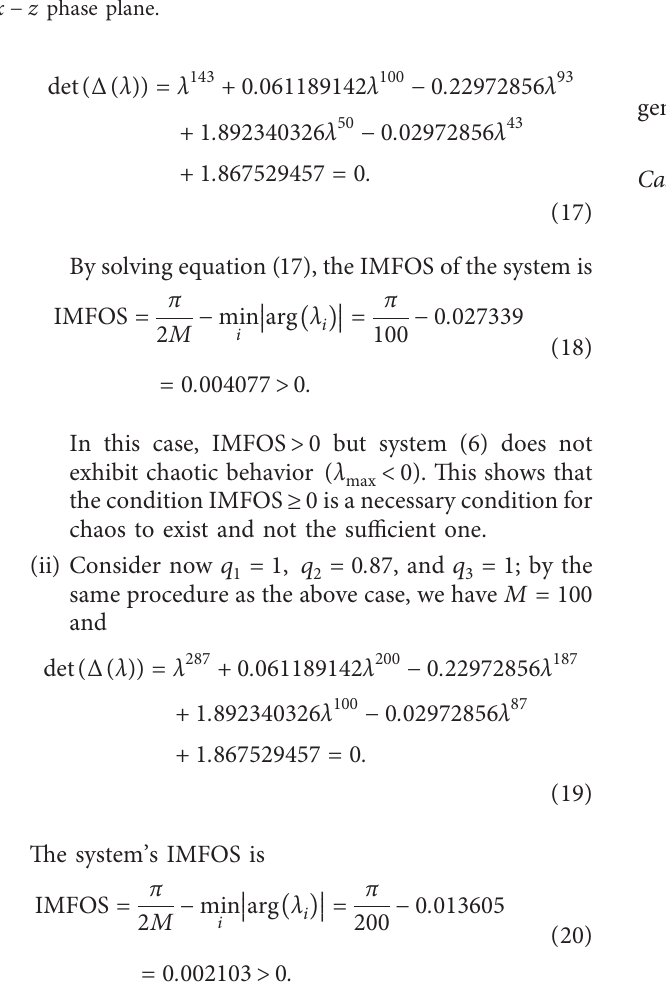
� 0 . 57 and q � q � 1 projected onto (a) the x − y phase plane and (b) the 1 2 3